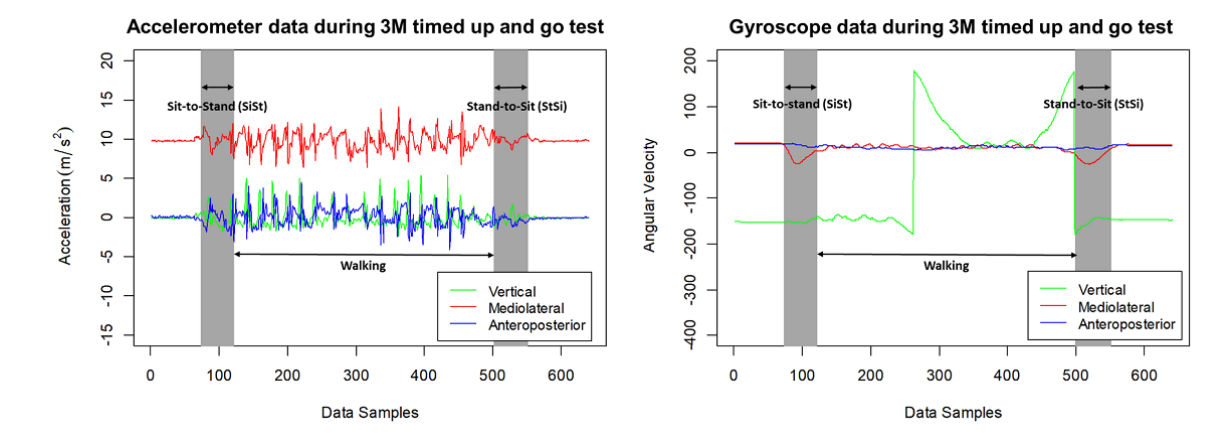
Figure 4. Example of segmented 3-meter (3M) timed up and go tasks using (left) accelerometer data and (right) gyroscope